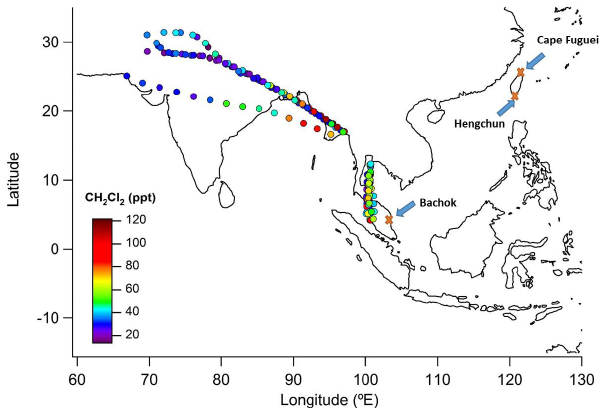
Figure 1. Map of the region showing the location of each CARIBIC sample. The markers have been coloured according to their CH 2 Cl 2 concentration to highlight the regions where enhanced levels of VSLSs were observed. Also shown are the approximate locations of the three surface stations (orange